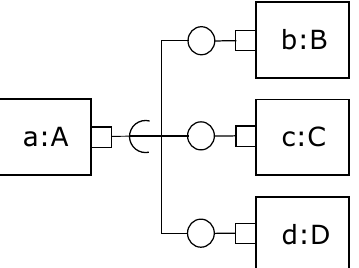
Figure 1. Single requester connected to multiple providers.